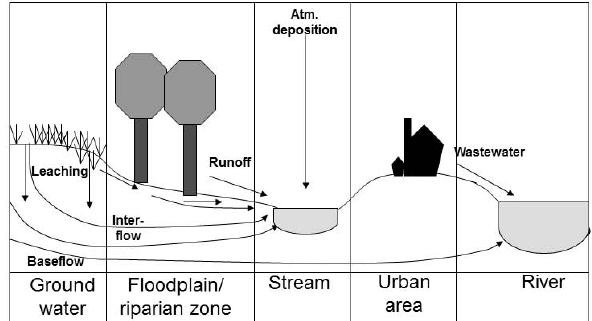
Fig. 1. Schematic of the hydrological system in river basins, in- cluding the soil, groundwater, riparian zone and floodplain, and the stream or river, and with wastewater flows from urban